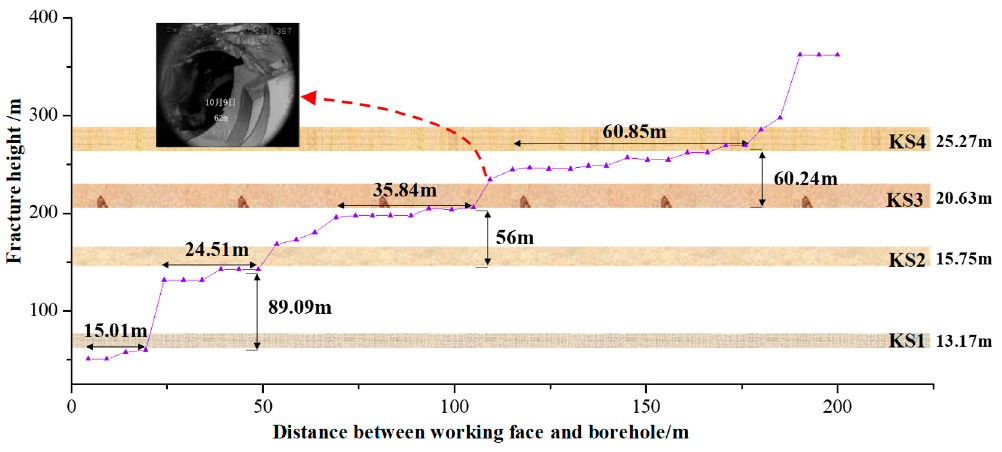
Figure 9. Fracture height curve.